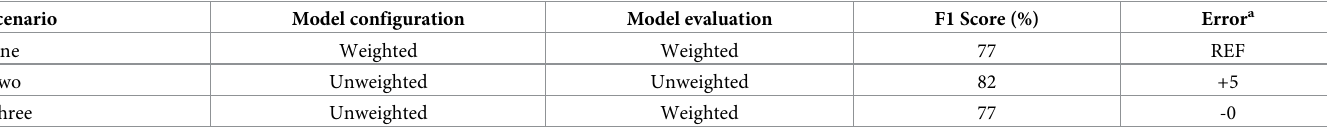
Table 2. Performance of unweighted versus weighted gradient boosting model implementations using data from the National Health and Nutrition Examination Survey III.